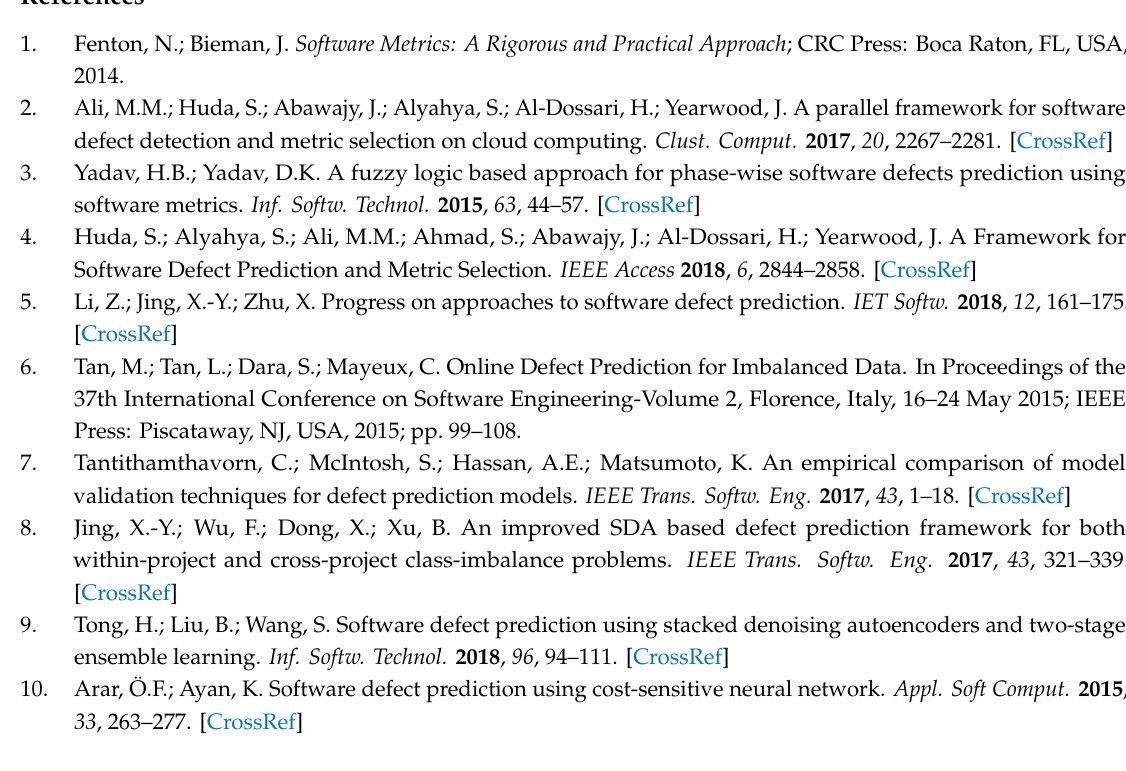
Boldface typeface indicates the lowest value for each FS